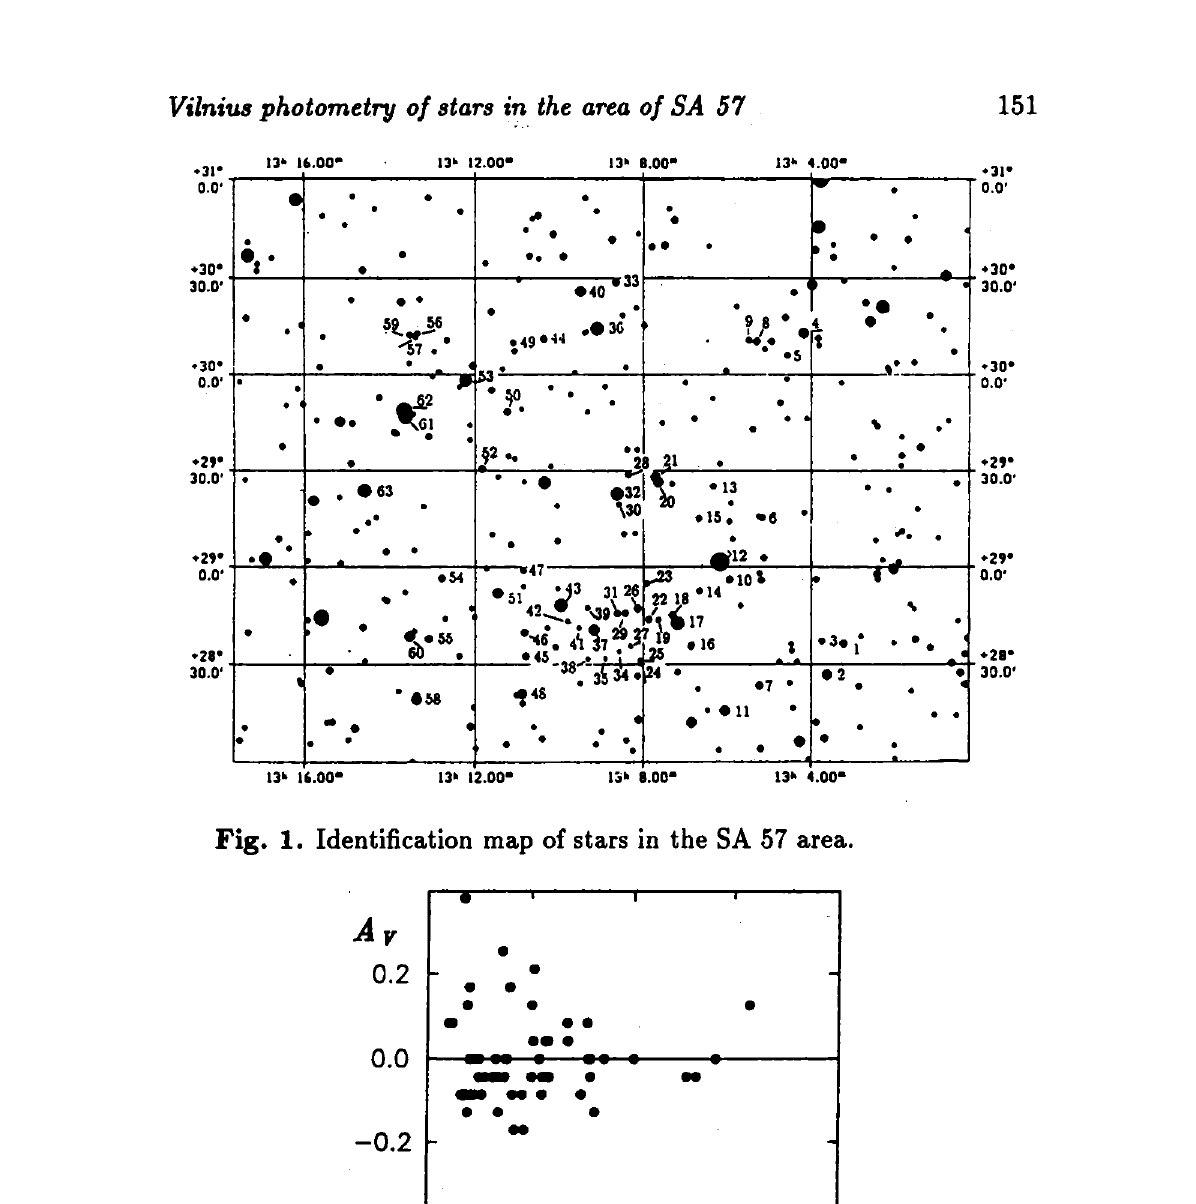
Fig. 2. Dependence of interstellar extinction Ay on distance. Stars Nos. 6, 8, 30, 49 are not